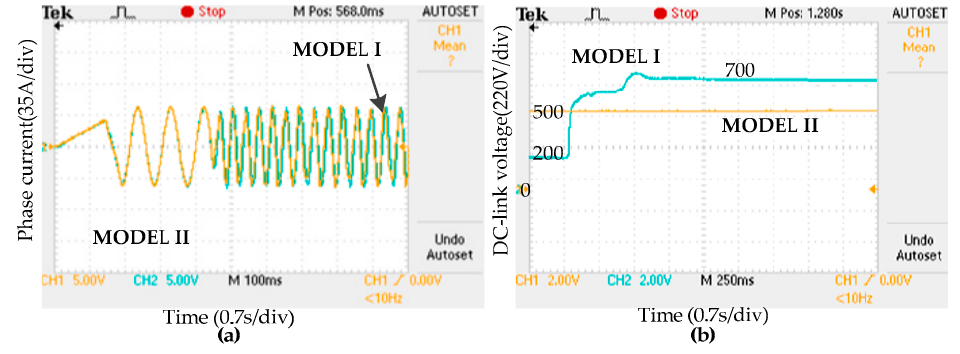
Figure 26. The phase current and the bus voltage value of two models under T e* = 190 Nm. ( a ) the phase current; ( b ) the bus voltage.